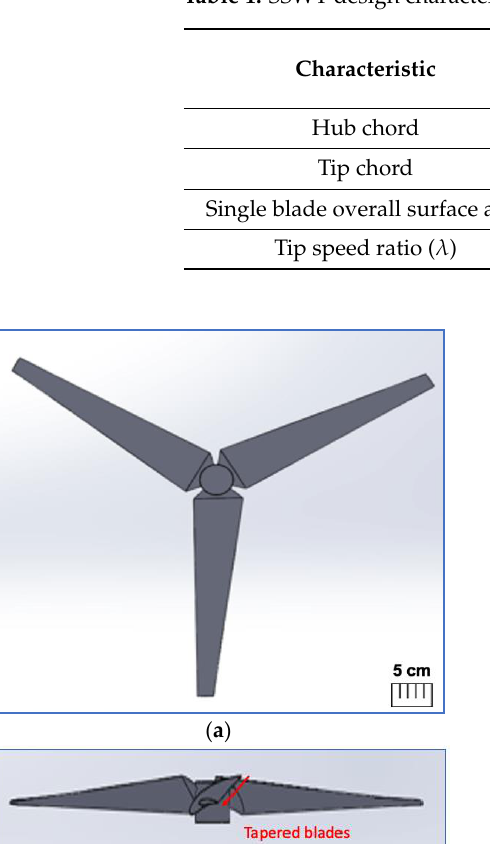
Table 1. SSWT design characteristics.